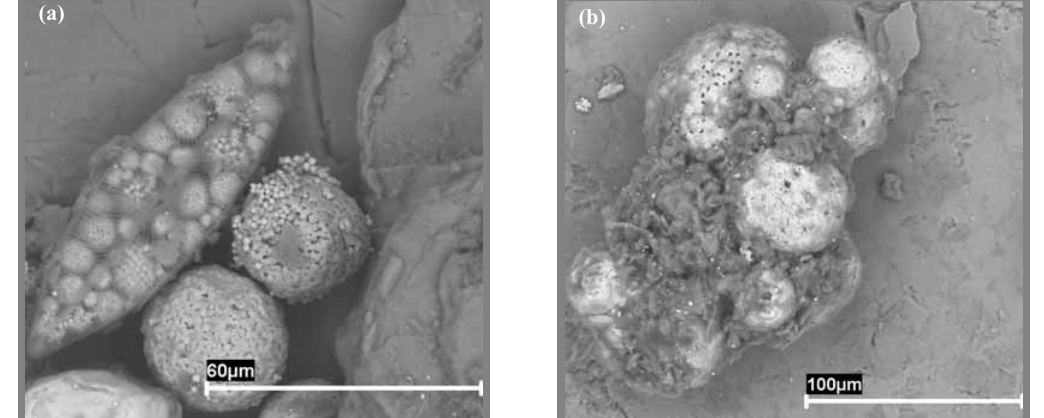
Figura 2. Microscopia eletrônica de varredura (MEV) de piritas na fração silte do horizonte 2Cgj2 do perfil H16, mostrando um exoesqueleto de diatomácea preenchido com o mineral (a) e outra, em processo de oxidação com silicatos incrustados ao redor (b).